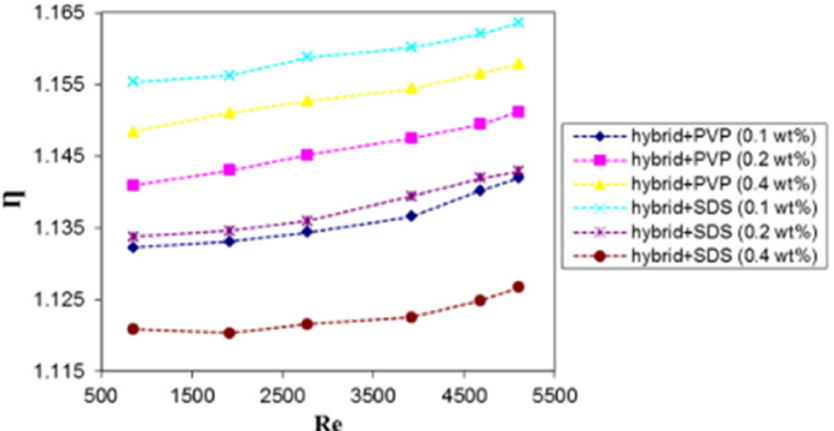
Figure 23. Thermal efficiency against Reynolds number for helical coil with hybrid NF containing SDS or PVP Adapted from [65].